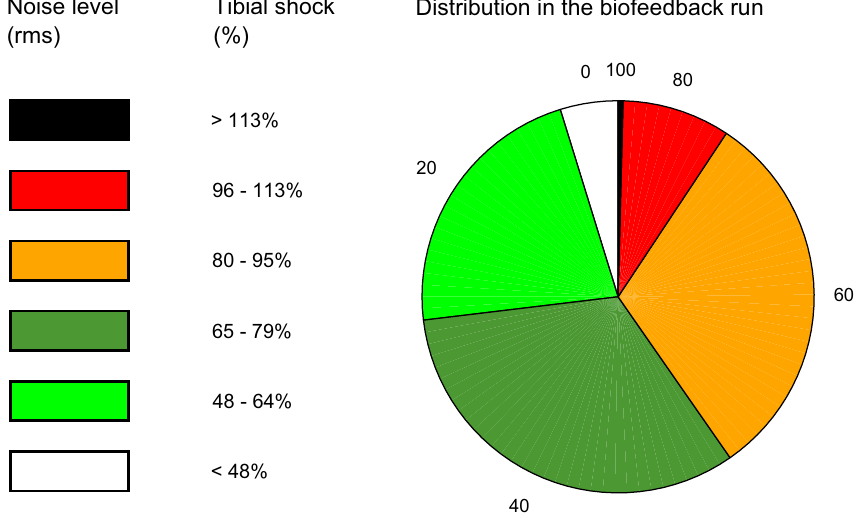
Figure 6. The proportion of the pink noise generated during the 20-min biofeedback run for the group of high impact runners. Level 0 represents the ‘music only’ category without superimposed noise. The level of noise loudness added to the synchronized music has been subdivided into 5 categories. Each level of noise loudness corresponds to a level of tibial shock relative to the baseline g -value of the runner, which was determined during the no feedback condition. The value corresponding to 100% of tibial shock is identical to the value of tibial shock determined in the no feedback condition. Tibial shock is here synonymous to the axial peak tibial acceleration, rms: root mean